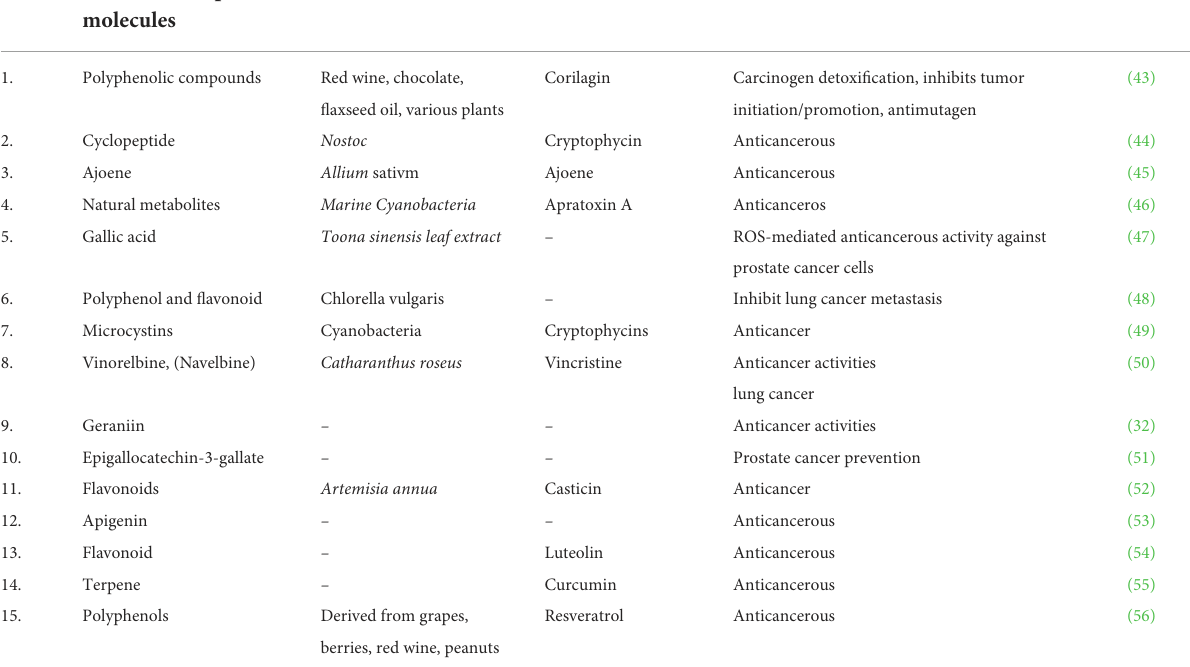
TABLE 1 Biologically active molecules showing anticancerous activity. S.